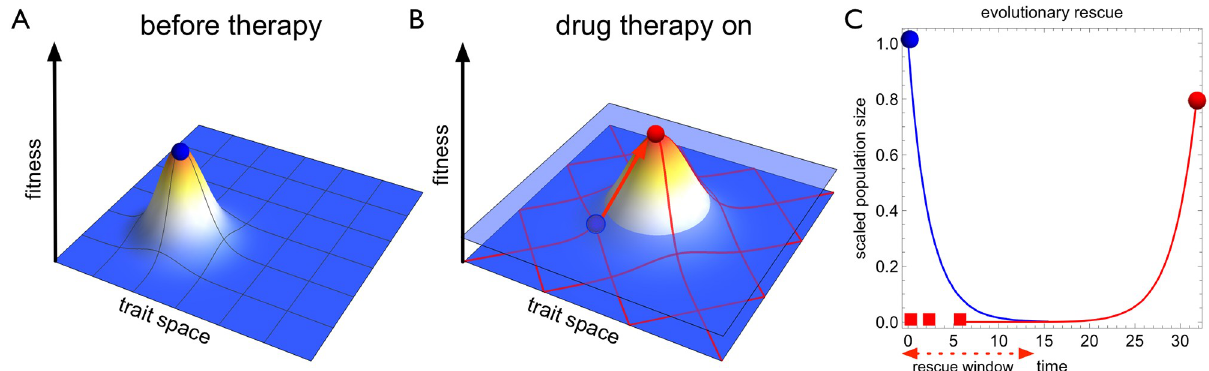
Fig 1. Drug-induced mutations realise an evolutionary collateral cost of therapy. A Before therapy the target cell population (blue circle) is well- adapted to its microenvironment. B Initiation of control (drug therapy) drastically changes the growth conditions of the target population pushing it below zero level of growth (light blue plane). At the same time opportunities to adapt to the new conditions create a selection pressure for resistance to evolve. Furthermore, the therapy can change the mutational wiring both qualitatively and quantitatively (red mesh). The effect of therapy on the mutational processes represent an evolutionary collateral damage of control, which can expedite the emergence of resistance (red arrow and circle). C The treatment eliminates the sensitive cell population (blue) but an evolutionary rescue can occur if a resistant mutant (red squares) manages to successfully establish during the rescue window. Here we derive optimal treatment strategies that minimise the probability of evolutionary rescue while taking into account drug-induced mutations.